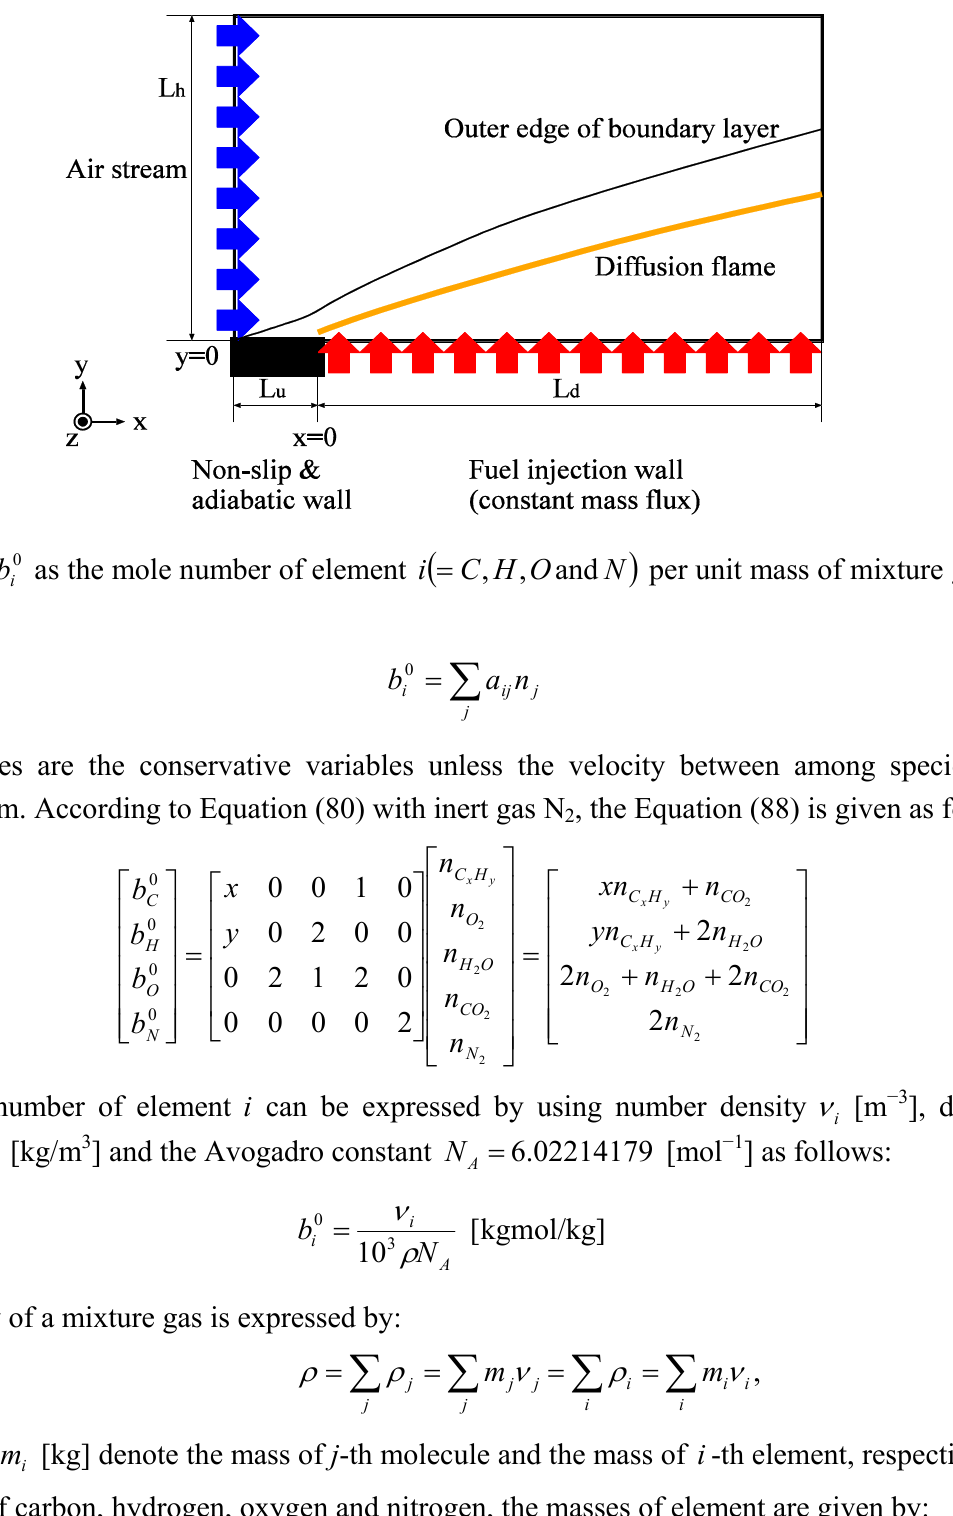
Figure 12. Schematic view of diffusion combustion in a laminar boundary layer on a flat